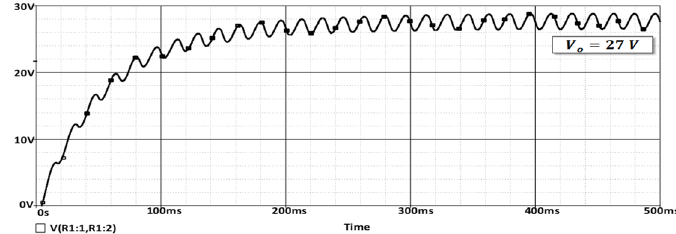
Figure 14. Output voltage plot of the resonant converter simulated in SPICE.